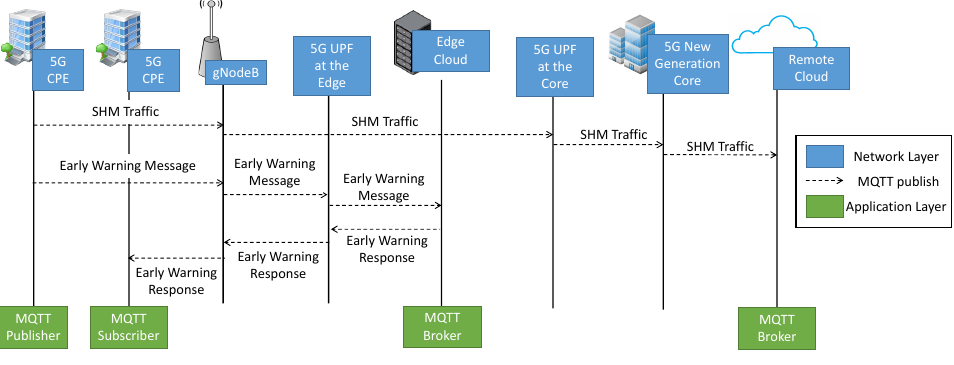
Figure 4. MEC for SHM and